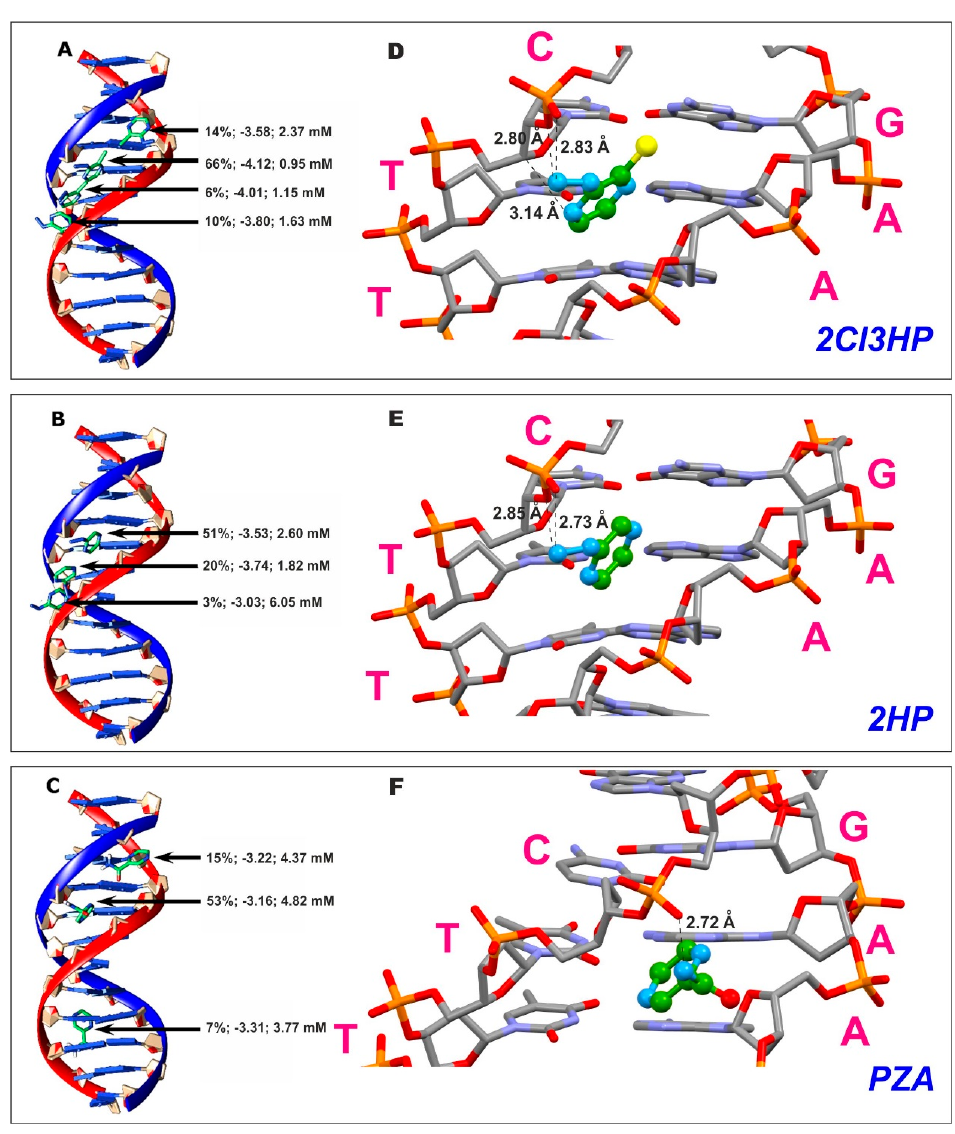
Figure 9. Molecular docked model of complexes ( A ) 2Cl3HP, ( B ) 2HP, and ( C ) PZA with B − DNA. For each received model, the population prevalence [%], Gibbs free energy [kcal/mol], and the inhibition constant [mM] as calculated by AutoDock 4.2 were given. The detailed interactions of the optimized structures ( D ) 2Cl3HP, ( E ) 2HP, and ( F ) PZA with B − DNA along with significant distances [Å]; the purple symbols mean: C is cytosine, G is guanine, T is thymine and A is adenine nucleobases. The following color scheme was used for the ligands: green for a carbon atom, blue for a nitrogen atom, red for an oxygen